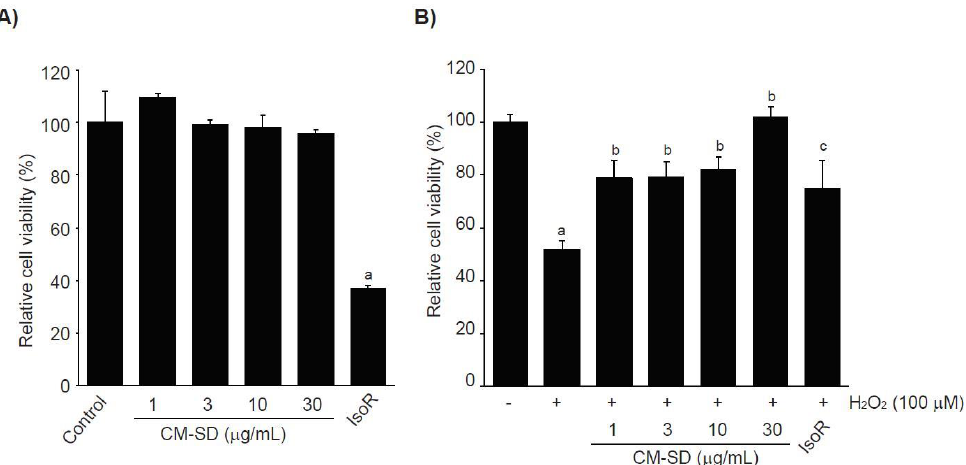
Figure 3. Effect of CM-SD on cell viability ( A ) and H 2 O 2 -mediated cytotoxicity ( B ) of C2C12 cells. Values are expressed as mean ± SD of six separate experiments. a p < 0.01, significant as compared with control by Dunnett’s T3 test; b p < 0.01, c p < 0.05, significant as compared with H 2 O 2 -treated cells by Dunnett’s T3 test.